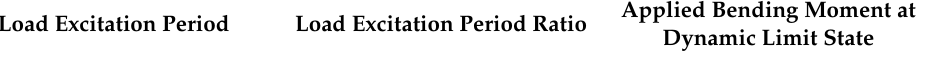
Table 7. Comparison of applied ultimate moment ratio at dynamic limit state of box girder (Model M2) with various load duration